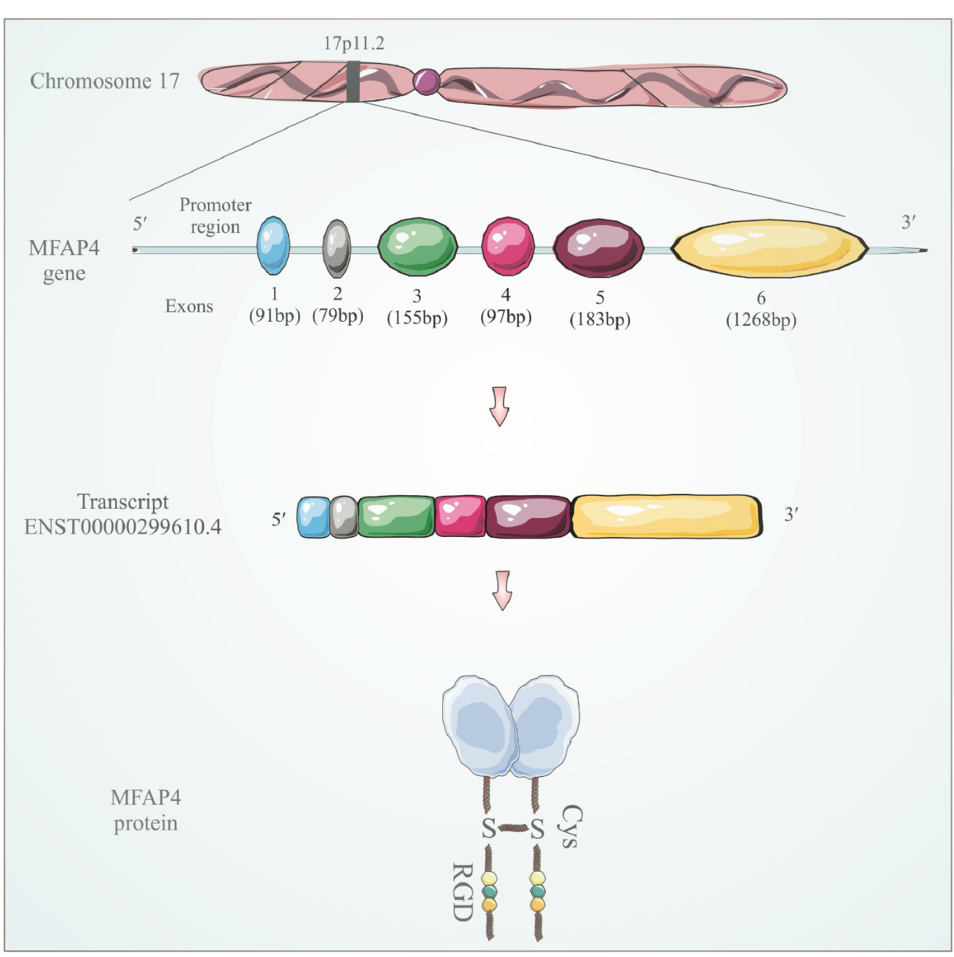
Figure 1. Representation of the MFAP4 gene structure based on MFAP4 -201 transcript (ENST00000299610.4). The MFAP4 gene is located on chromosome 17 and comprises six exons. It is translated to MFAP4 dimeric protein containing N-terminal RGD motif and C-terminal globular fibrinogen-related domain (blue).